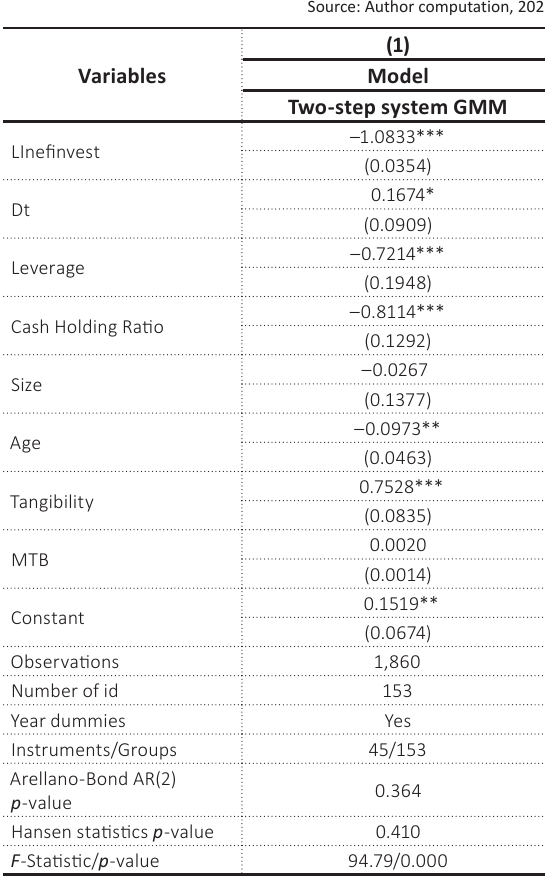
Table 3. Impact of shareholder distraction on inefficient investment